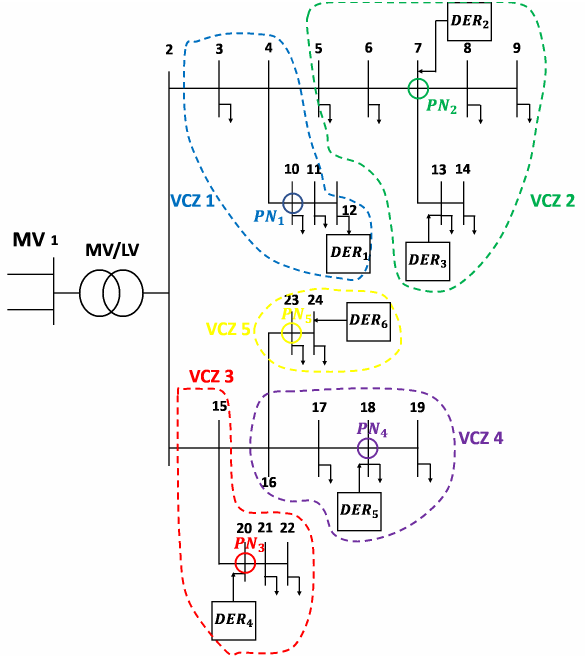
Figure 2. A 24-bus test system including 6 DERs and partitioned in 5 VCZs. Table 1. Parameters of the local voltage PI